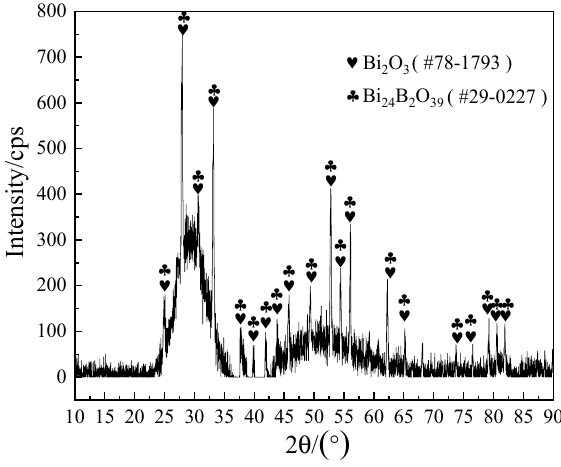
Figure 11. XRD patterns of the brazing joint fracture from Figure 9b.